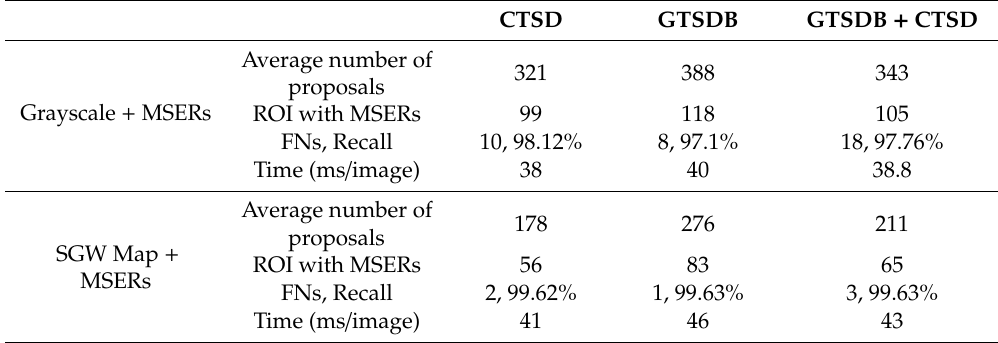
Table 1. The comparison of different detection metrics for the grayscale + maximally stable extremal regions (MSERs), and simplified Gabor wavelets (SGW) Map + MSERs approaches.